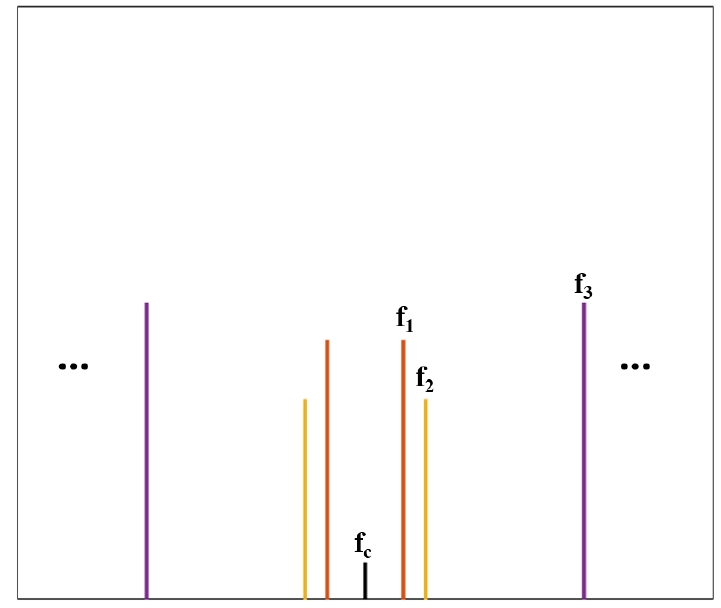
Figure 2. ± 1st-order optical-modulated signal spectrum after